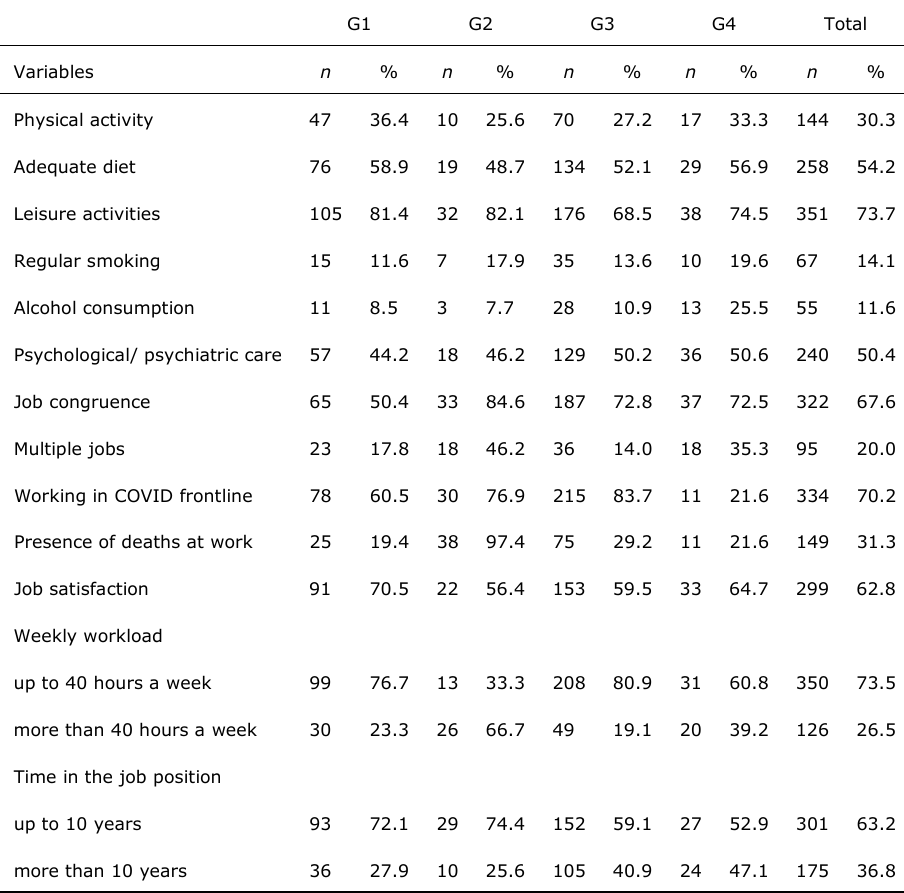
Table 2. Participants´ lifestyle and job variables ( n =476)